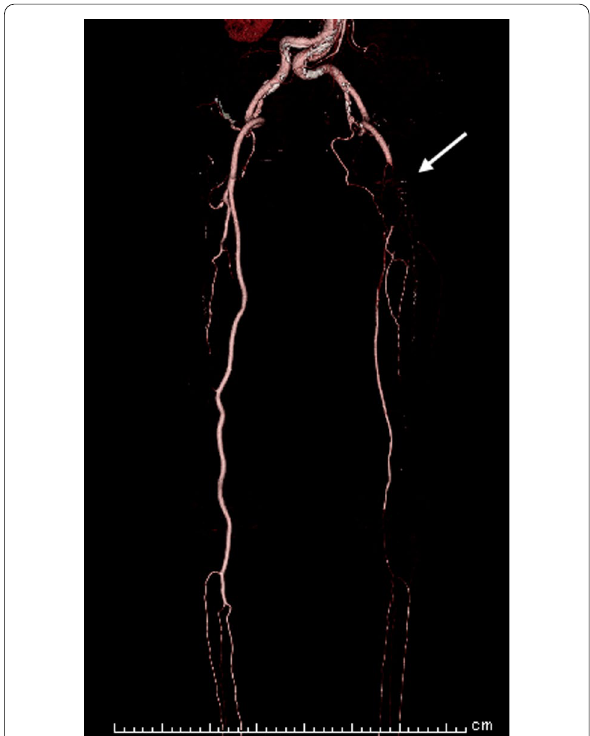
Fig. 1 Preoperative computed tomography. Preoperative computed tomography shows thrombi in the left common femoral, superficial and deep femoral, and popliteal arteries